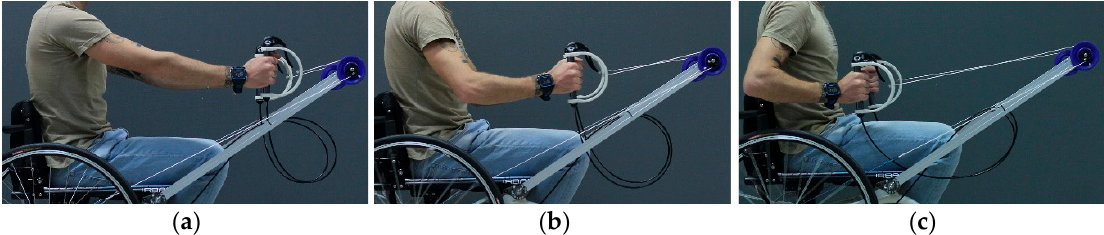
Figure 14. Innovative gesture during the indoor test of the first prototype Handwheelchair.q01. ( a ) t 0 ,